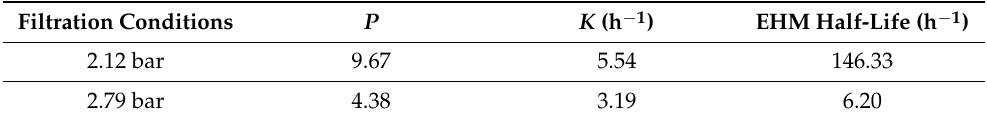
Table 10. EHM parameters for the regressions obtained in Example 4 at 2.5 m/s and different TMPs.